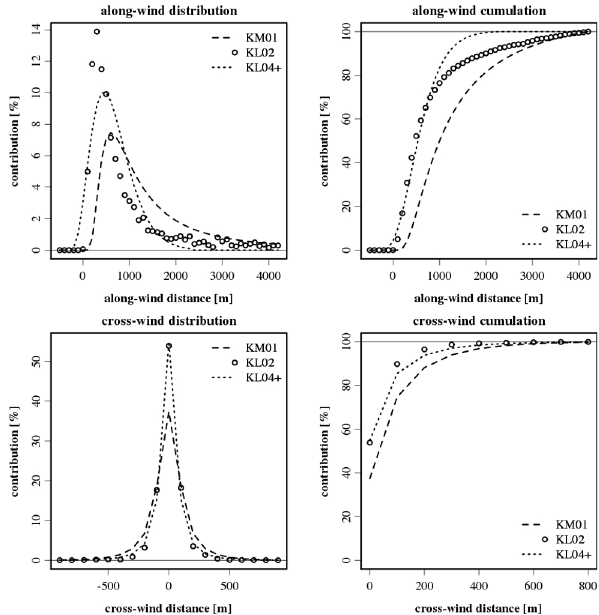
Fig. B1. Cross-wind and along-wind integrated distributions of the footprints for case 2, z = 100m from Markkanen et al. (2009). Up- per and lower panels display longitudinal and cross-sections, re- spectively. The footprint weight distributions are shown on the left side, and the cumulative distributions are shown on the right side.